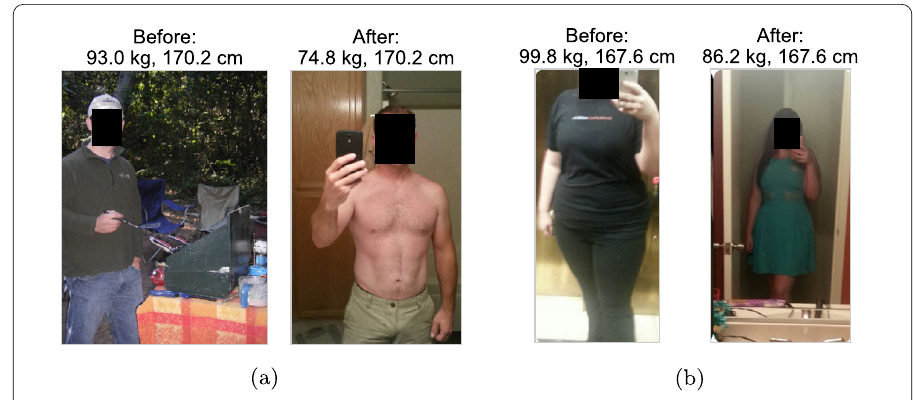
Figure 1 Two samples from the dataset. Each sample contains a “before” and an “after” picture. The height and weight before and after are shown on the top